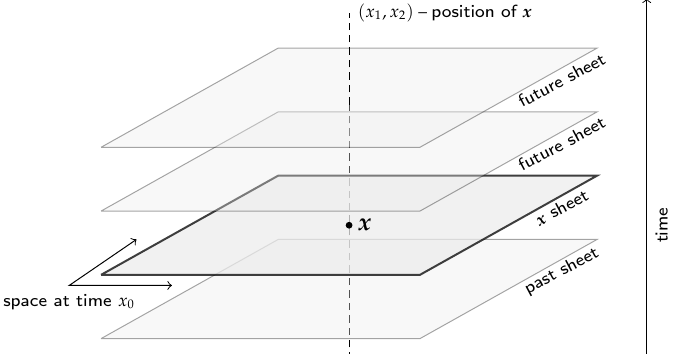
Figure 1. The whole space–time centered about the event x of coordinates ( x 0 , x 1 , x 2 ) : x is located at ( x ) in a bi-dimensional space at time x = ( x ) . 0 : x 0 , x 1 , x 2 1 , x 2 To define a spatio-temporal distance, we mimic the structure of the Minkowskian relativistic metric [27,28,34]. According to the conventions of relativistic physics, we call event any space–time element x = ( x o , x 1 , x 2 . . . x n ) , where x 0 is the time and x 1 , x 2 . . . x n are the spatial